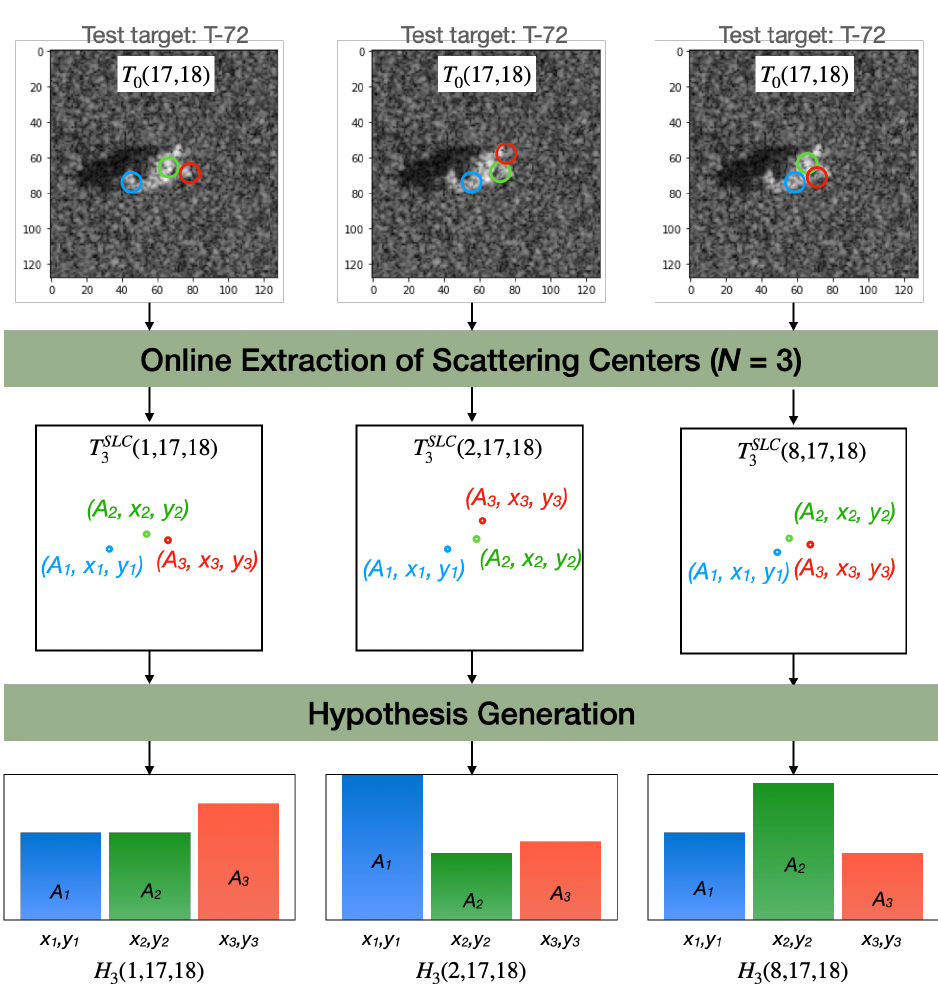
Figure 10. Illustrated example of three hypotheses generation by the SLC-based approach. Each hypothesis (BMP-2, BTR-70 and T-72 classes) was generated by extracting three scattering centers from the T-72 test target accordingly to the respective class